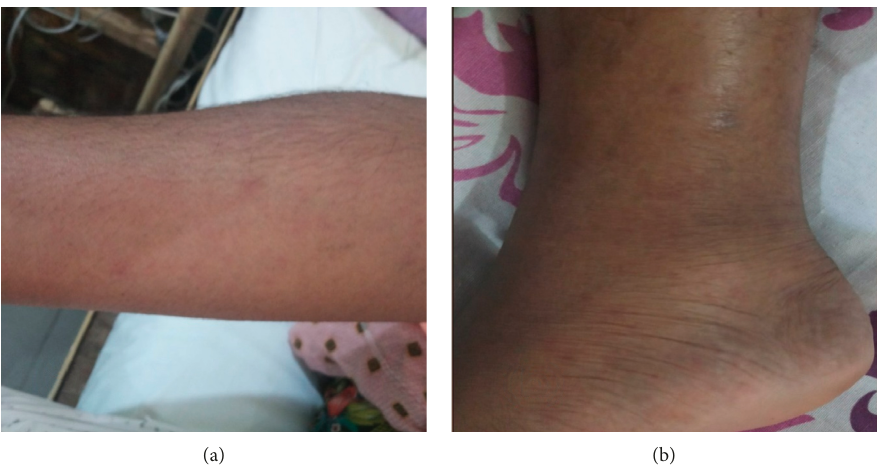
Figure 1: Generalized erythematous maculopapular rash at the (a) upper limb and (b) lower